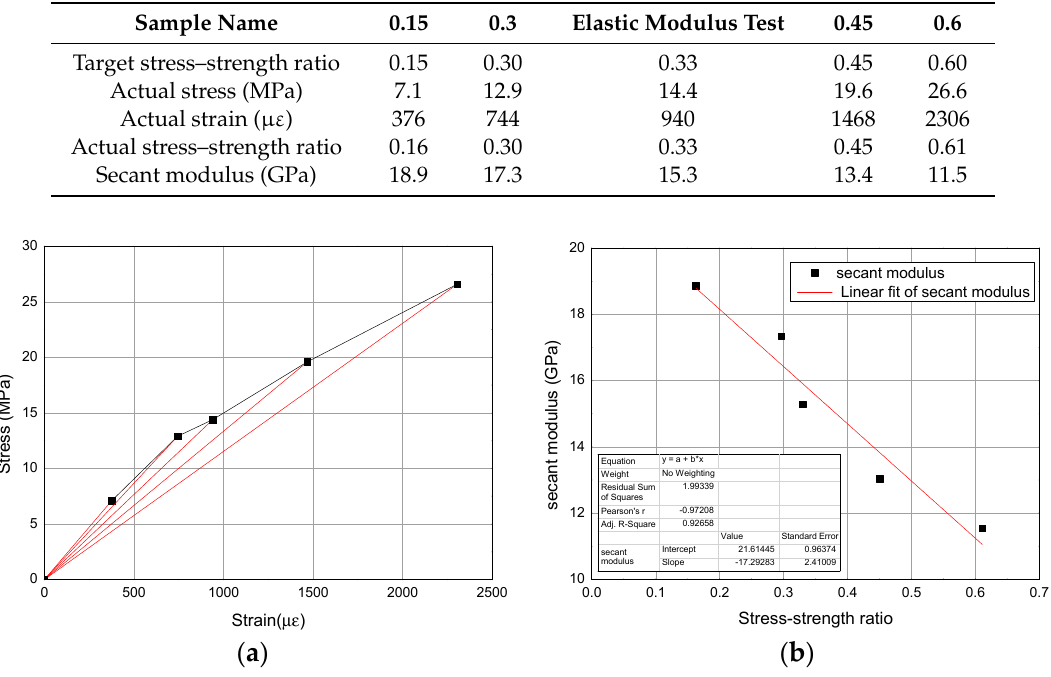
Figure 9. Secant modulus of AAS under different stress–strength ratios and their linear fit. ( a ) stress- strain relation; ( b ) linear fit of scant modulus under different stress-strength ratio.